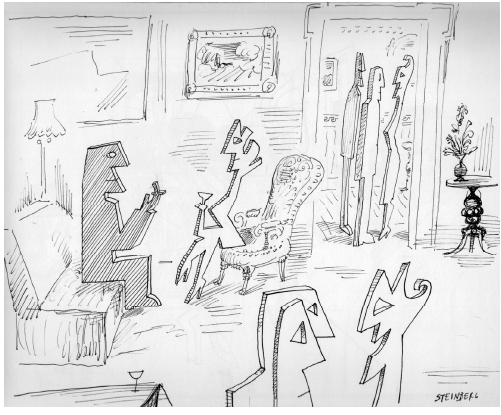
Figure 13. M. C. Escher, Reptiles , 1943.